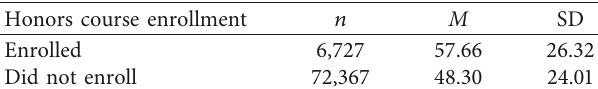
Table 5: Descriptive statistics for support for learners benchmark scores by honors course enrollment